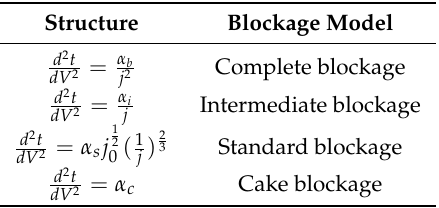
Table 4. Hermia fouling models